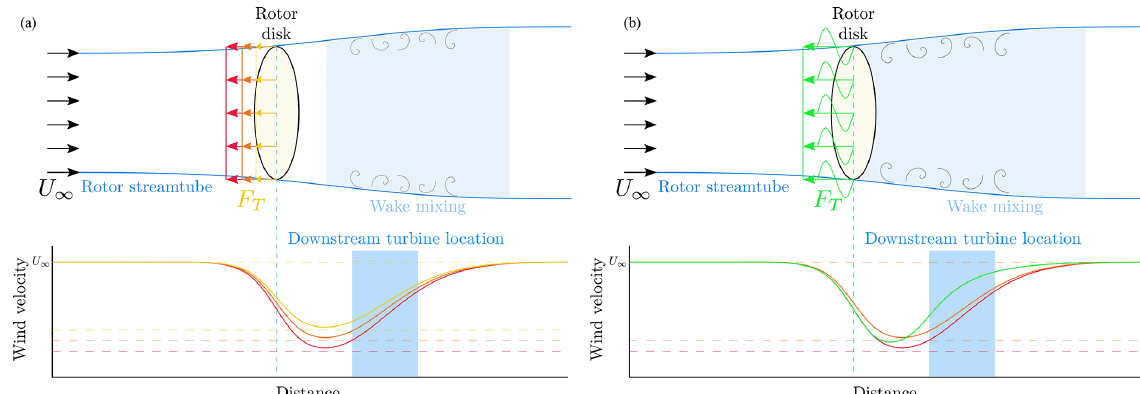
Figure 1. A schematic representation of a wind turbine in a flow field, showing the working principles of static (a) and dynamic induction control (b) . At the top, the turbine is simplified as a rotor disk, and its streamtube – the area where the wind speed is affected by the turbine settings – is depicted. The force F T exerted on the wind is shown for different induction settings a , where red depicts “greedy” settings that result in optimal single-turbine power capture ( a = 1 / 3). The orange ( a ≈ 0 . 3) and yellow ( a ≈ 0 . 25) lines depict arbitrary static derating settings that can be achieved by changing either the generator torque or the collective pitch angles of the turbine. The green lines represent periodic DIC. The bottom figures show the corresponding wind velocity profiles, with respect to inflow velocity U ∞ , as a function of the distance from the turbine. The area highlighted in blue is where a downstream turbine is typically